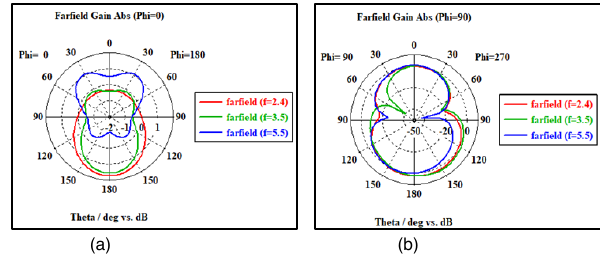
Figure 21. Variation in maximum gain vs frequency for UWB-CMSA with hybrid EBG. Fig. 21 reveals simulated and measured gain over the entire band, minimum value of gain is 1.00 dB at 4.8 GHz and maximum value of 5.3 dB at 11.4 GHz. Fig. 22 shows combined radiation patterns at phi 0 and phi 90 for 2.4 GHz, 3.5 GHz, and 5.5 GHz, and is evident that backward radiation is suppressed more when compared with previous designs and is responsible for SAR reduction to some extent.